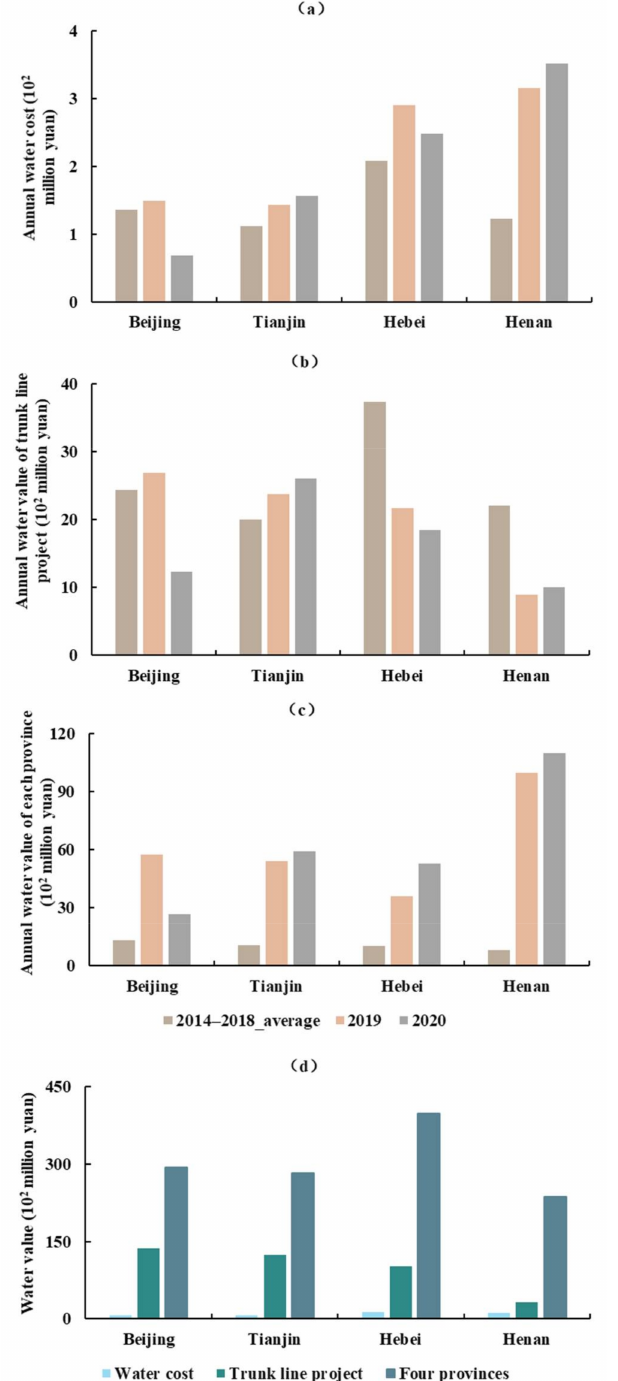
Figure 6. Water value in each province. ( a ) Annual water cost, ( b ) annual water value of the trunk line project, ( c ) annual water value of each province, and ( d ) comparison of water value for the above